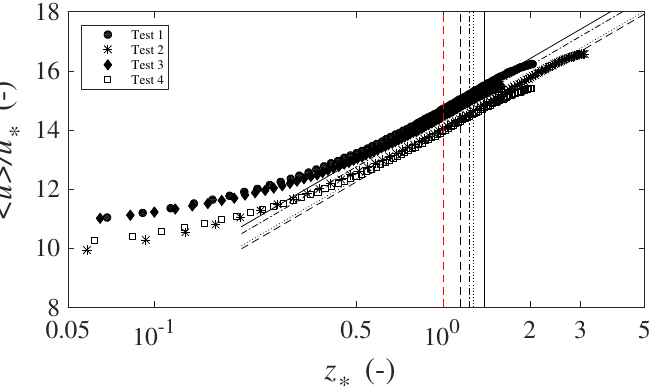
Figure 5. Double-averaged longitudinal velocity profiles and regression lines for Scenario 1 ( κ = 0.405), where z ∗ = ( z − ∆ ) / ( k s − ∆ ) . The red vertical line represents the lower bound of the linear reach for all tests, whereas the black vertical lines define the upper bound determined for each test. Test 1 is identified by a solid line, Test 2 by a dash-dot line, Test 3 by a dashed line, while Test 4 by a dotted line.